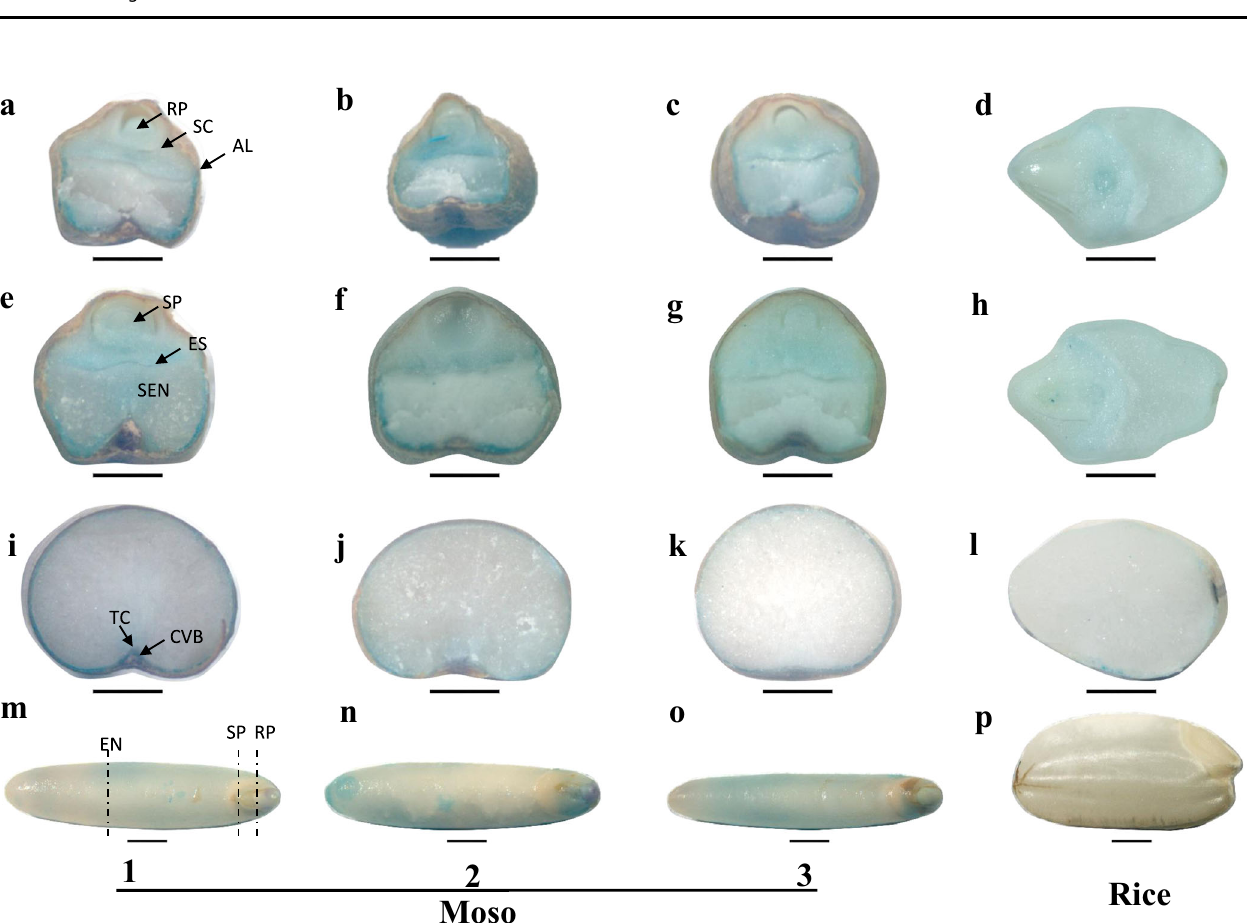
Fig. 4 Localisation of Fe in Moso bamboo seeds and rice. Fe in transverse sections of root primordium ( a , b , c , d ), shoot primordium ( e , f , g , h ), and endosperm ( i , j , k , l ) of Moso bamboo seeds ( a , b , c , e , f , g , i , j , k ) and rice ( d , h , l ) were stained by Prussian blue staining. RP root primordium; SP shoot primordium; EN endosperm; SEN starchy endosperm; SC scutellum; ES epithelium of scutellum; AL aleurone layer; TC transfer cell; CVB crease vascular bundle. Scale bars = 1000 μ